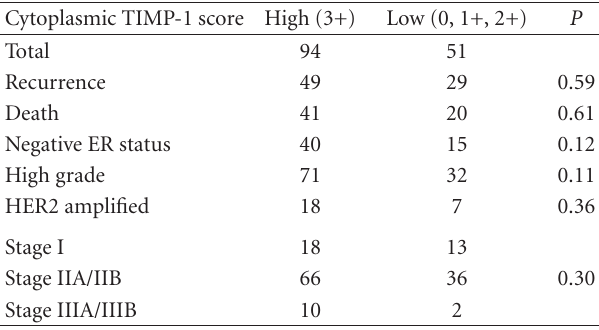
Table 5: Occurrence of clinical/pathological features in patients with high levels of TIMP-1 protein ( n = 94) compared to patients with low levels of TIMP-1 protein ( n =